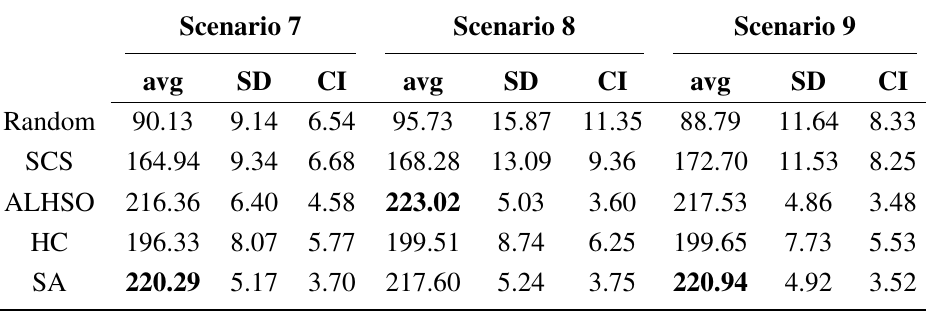
Table 5. Utility in scenarios with 100 APs and 500 sensors.